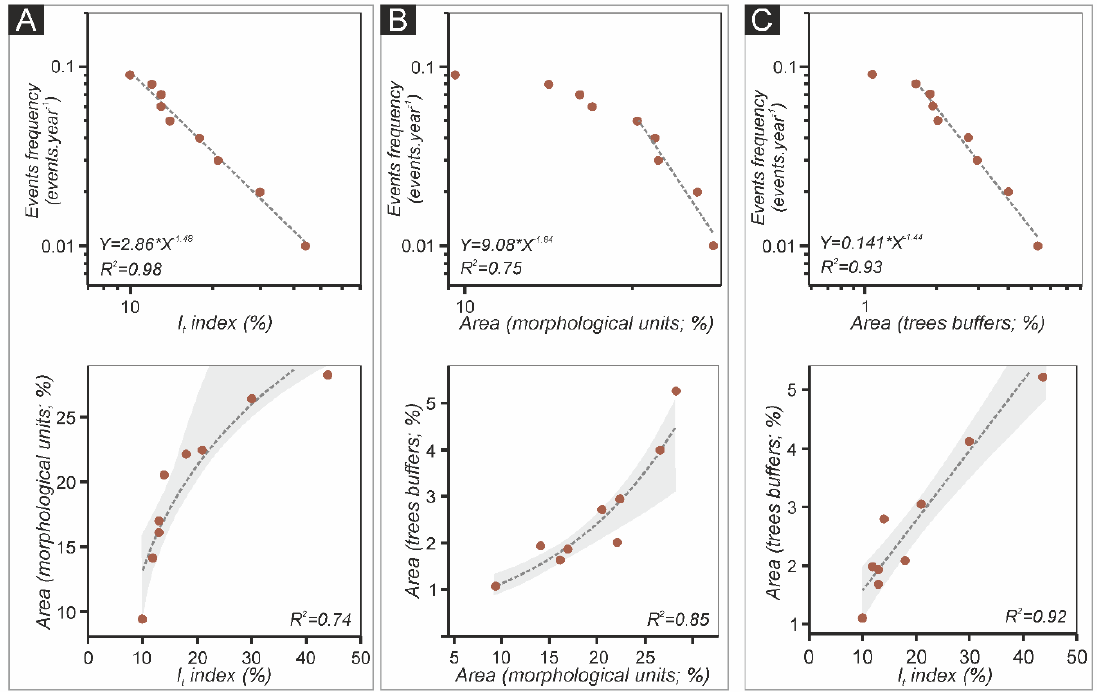
Figure 4. The magnitude–frequency relationships of the Mazák landslide, and the relationships among the methods of expressing magnitude ( A – relationships for I t index, B – relationships for morphological units based area, C – relationships for trees buffers based area).